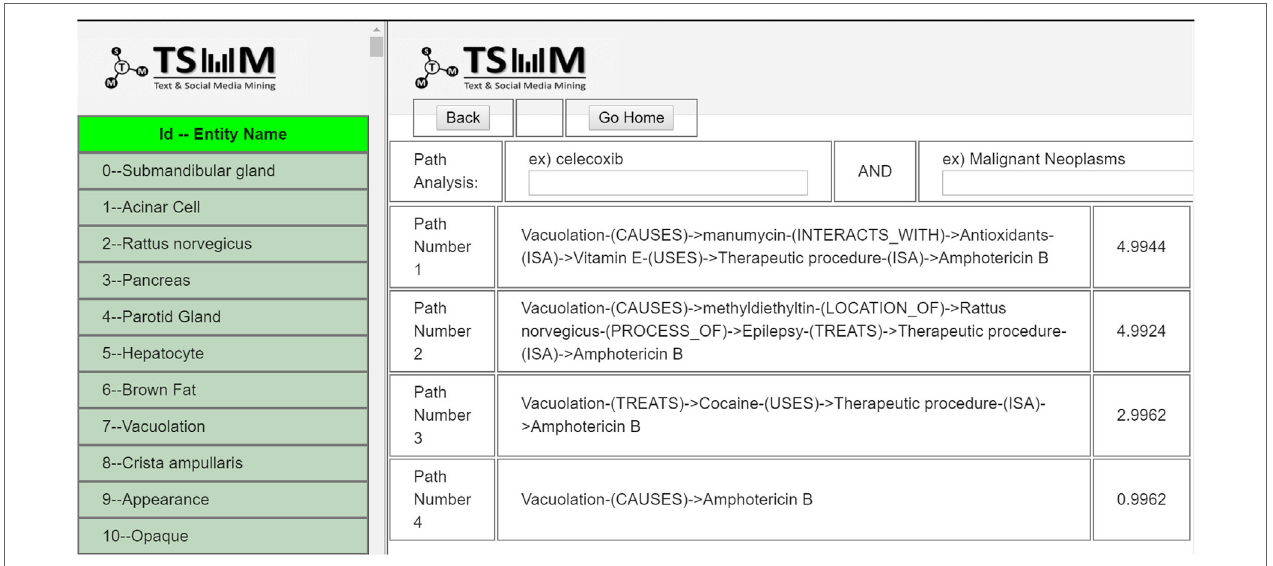
FigUre 14 | The results’ page for the generated